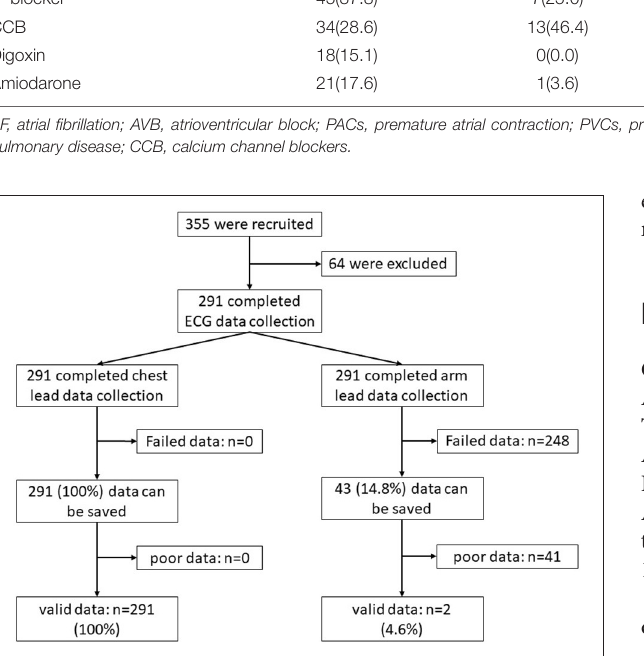
FIGURE 3 | Participant selection and summary of ECG